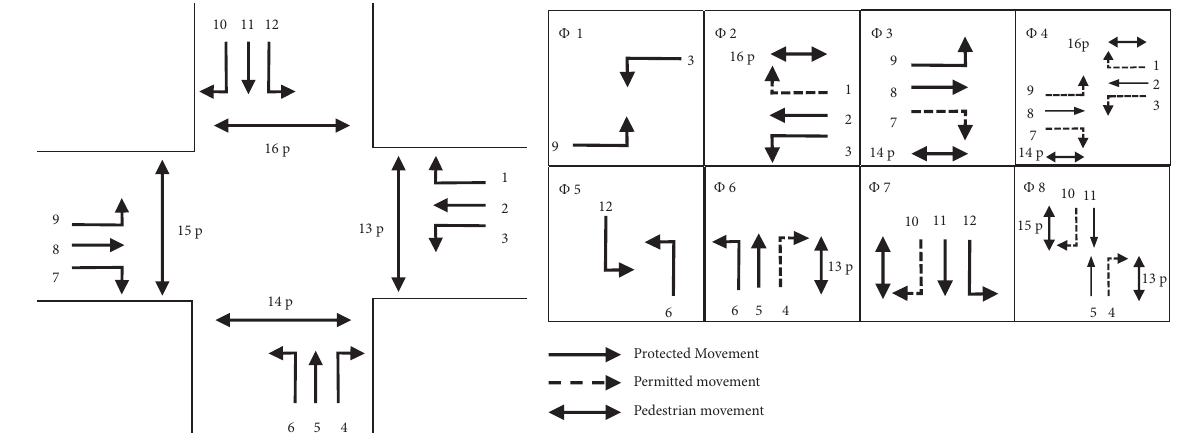
Figure 2: Intersection traffic movements and phasing sequence.